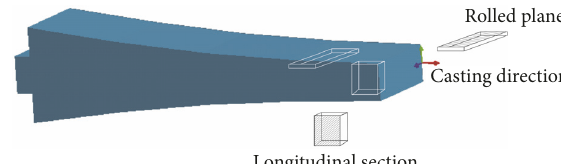
Figure 5: Schematic illustration of sample selection for microstruc- ture and texture